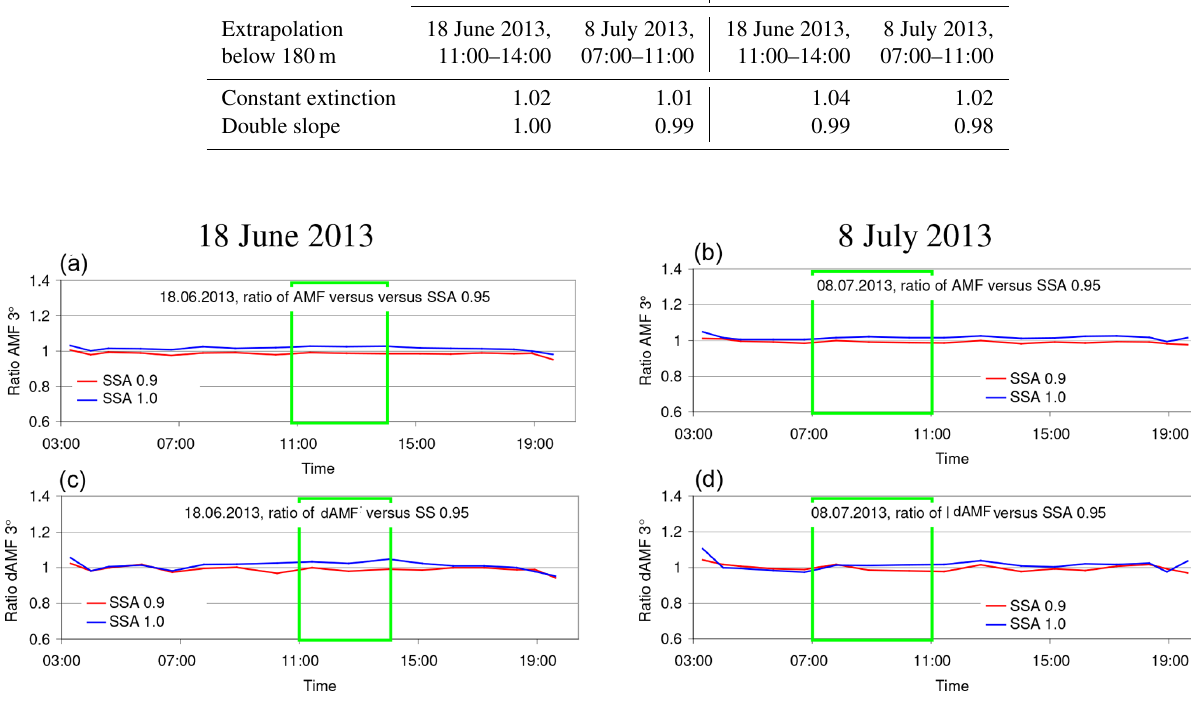
Figure A9. Ratios of the O 4 AMFs (a, b) and O 4 dAMFs (c, d) derived for different aerosol single-scattering albedos vs. those for the standard settings (single-scattering albedo of 0.95) for both selected days.